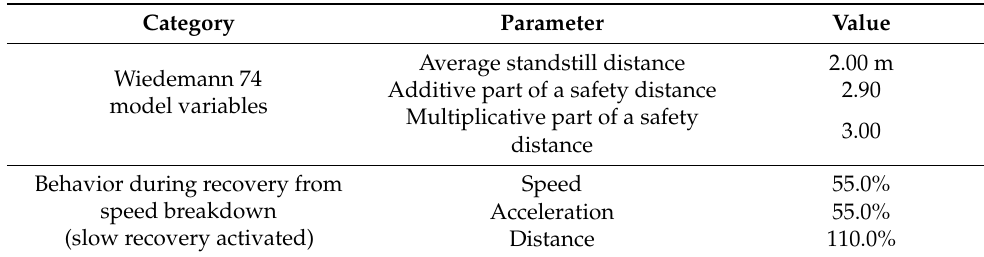
Table 1. Driver behavior variables in the microscopic